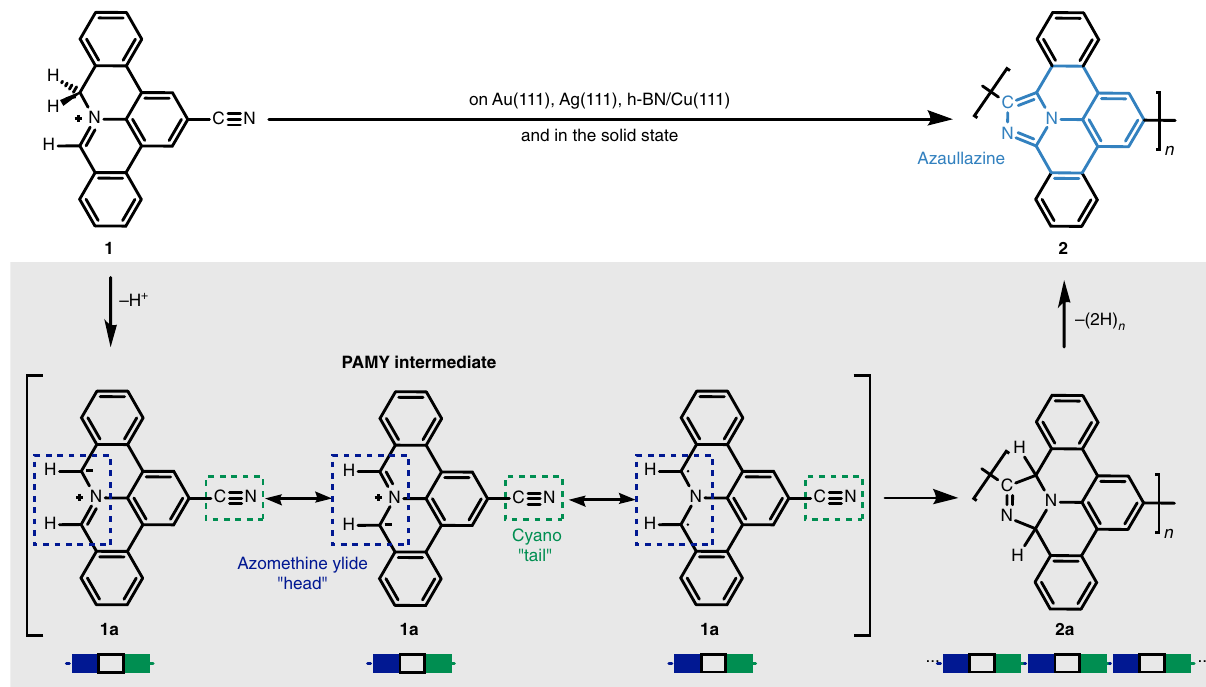
Fig. 1 Conceptual route for the reported synthesis of polyaromatic azaullazine chains. The thermally induced head-to-tail coupling of 1 was observed on Au(111), Ag(111), h-BN/Cu(111), as well as in the solid state. Bottom: Reactive PAMY species 1a as potential intermediates with af fi nity towards the cyano moiety, yielding intermolecular head-to-tail cycloaddition product 2a . Subsequent dehydrogenation affords polyaromatic azaullazine chains 2